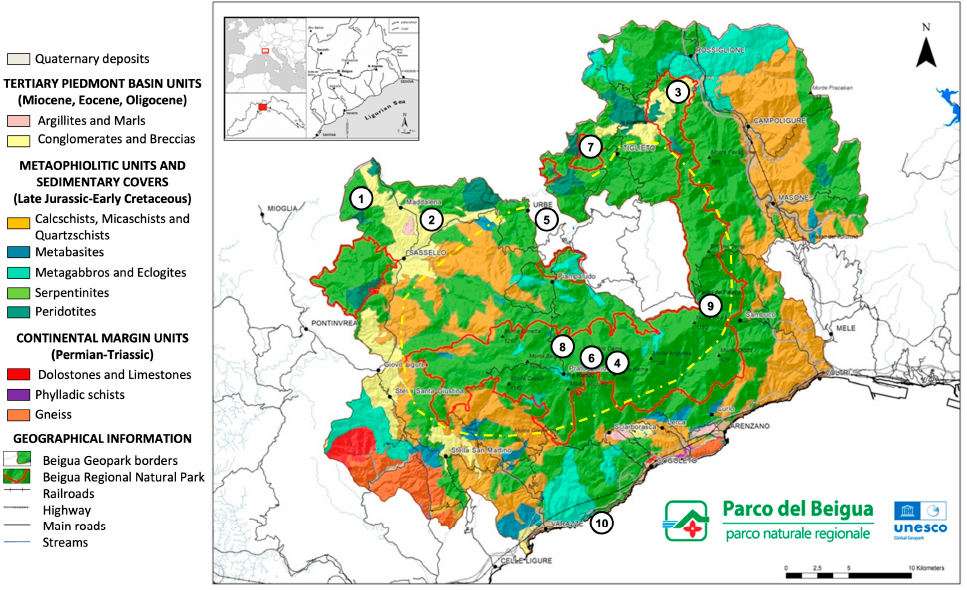
Figure 3. Simplified geological sketch of the Beigua Geopark area (Modified from “Geotouristic map of Beigua Geopark”); adapted with permission from Ref. [50]. The yellow dashed line indicates the area where eclogite and metarodingite lenses and dikes of various scale commonly occur within the meta-ophiolite. The numbers (1–10) indicate the location of the selected geosites described in the text.